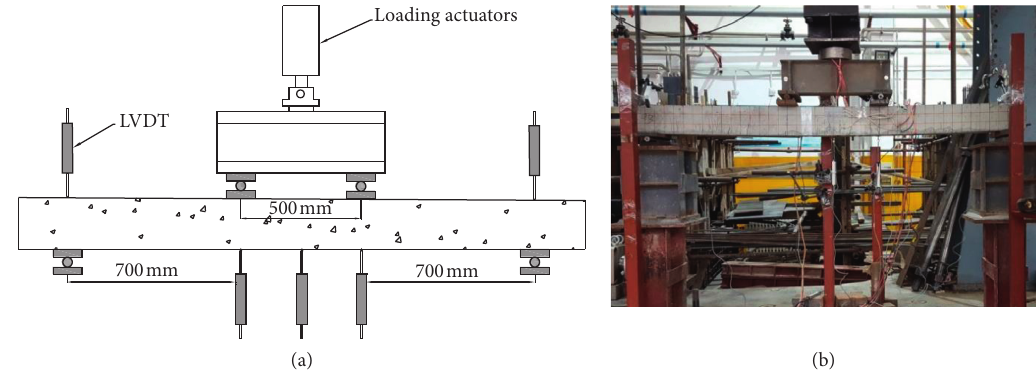
Figure 6: Schematic of the fatigue loading test setup. (a) Sketch of loading test equipment. (b) Loading test equipment.